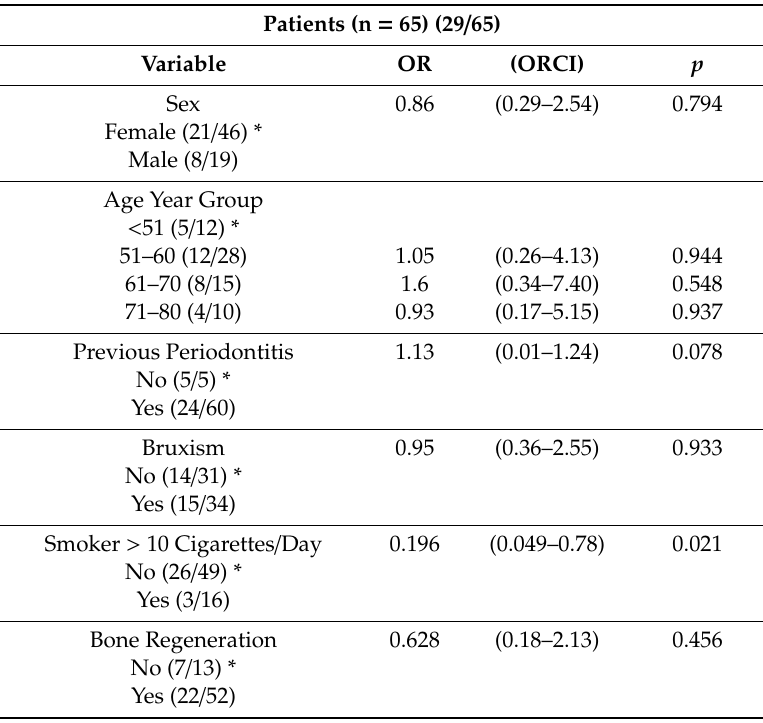
Table 7. Distribution of mechanical technical complications in the sample in relation to patient-based variables.